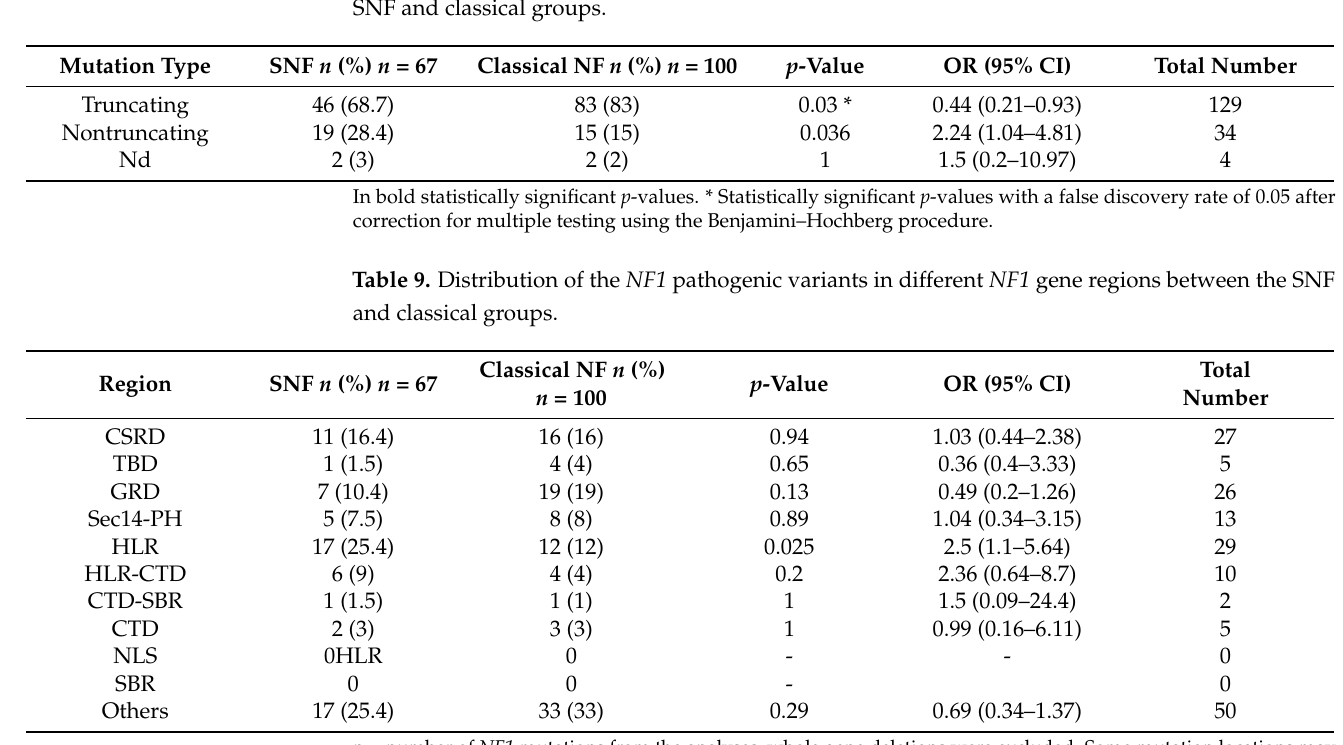
Table 8. Distribution of the NF1 pathogenic variant types (truncating/nontruncating) between the SNF and classical groups.